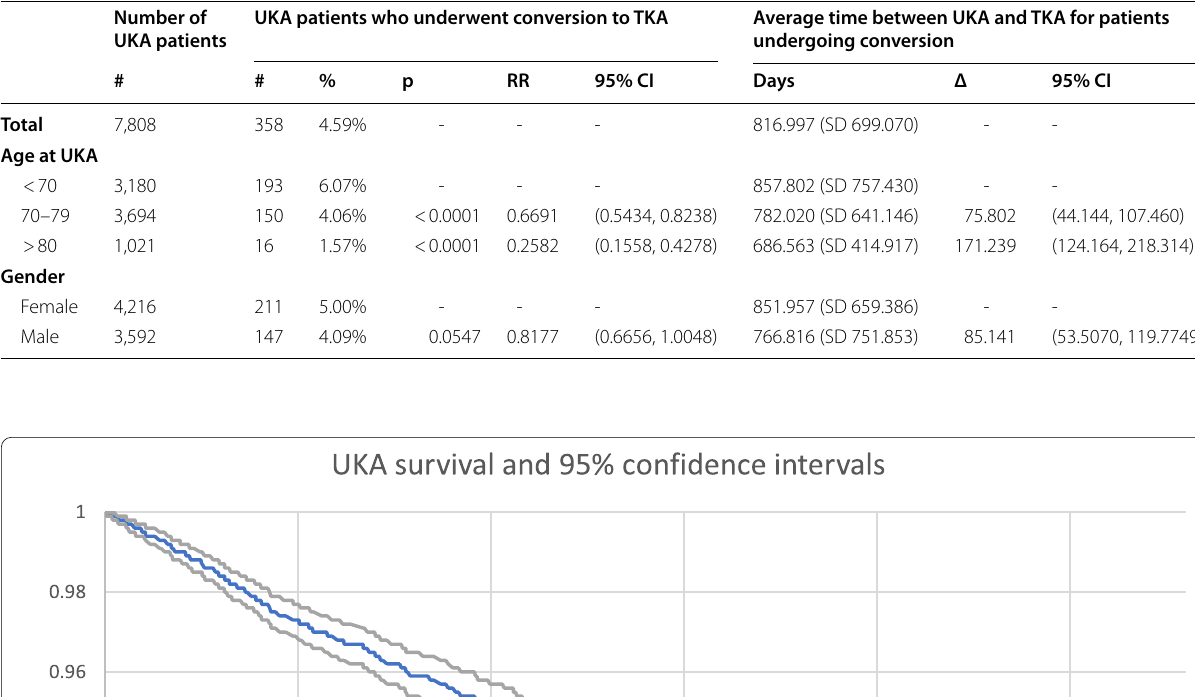
undergoing conversion